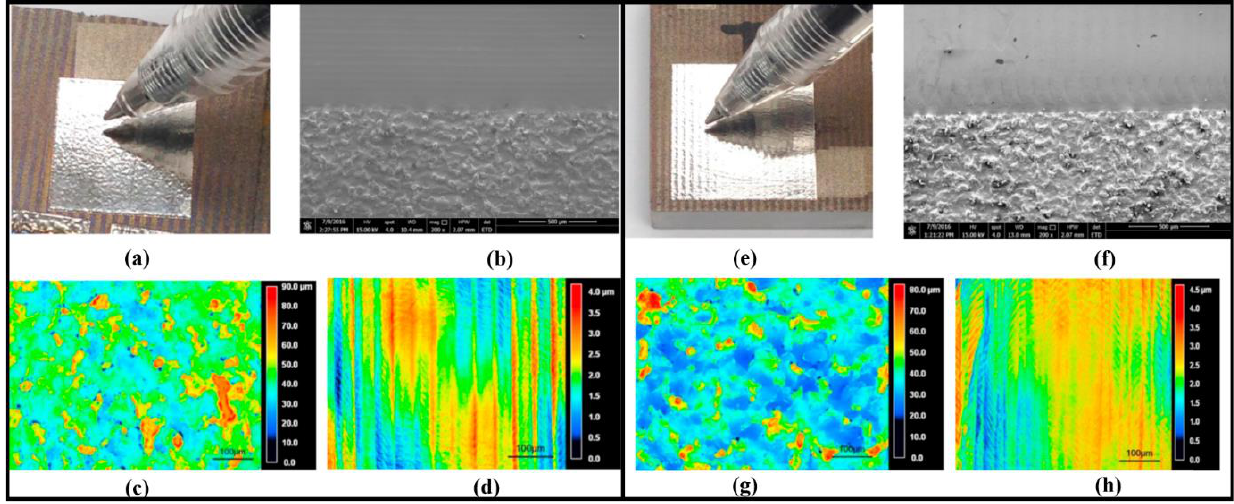
Figure 14. ( a – d ) Ti6Al4V alloy (laser-polished region, SEM, Topographies image of as-received and LP-ed surfaces), and ( e – h ) α + β Ti -alloy (laser-polished region, SEM, Topographies image of as- received and LP-ed surfaces) [79]; with permission from